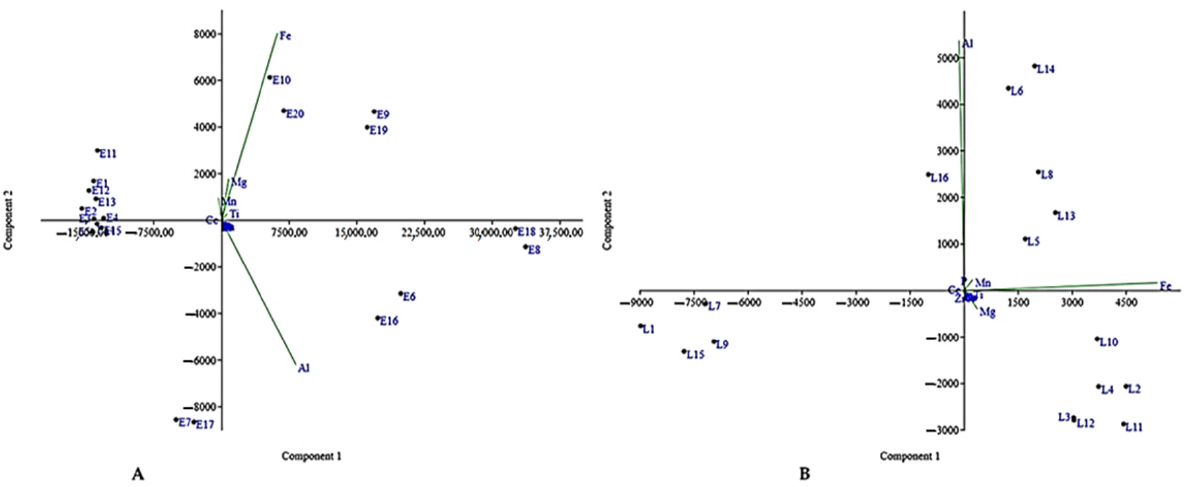
Figure 3. Principal component analysis for elements of ( A ) estuary and ( B ) littoral shelf sediment